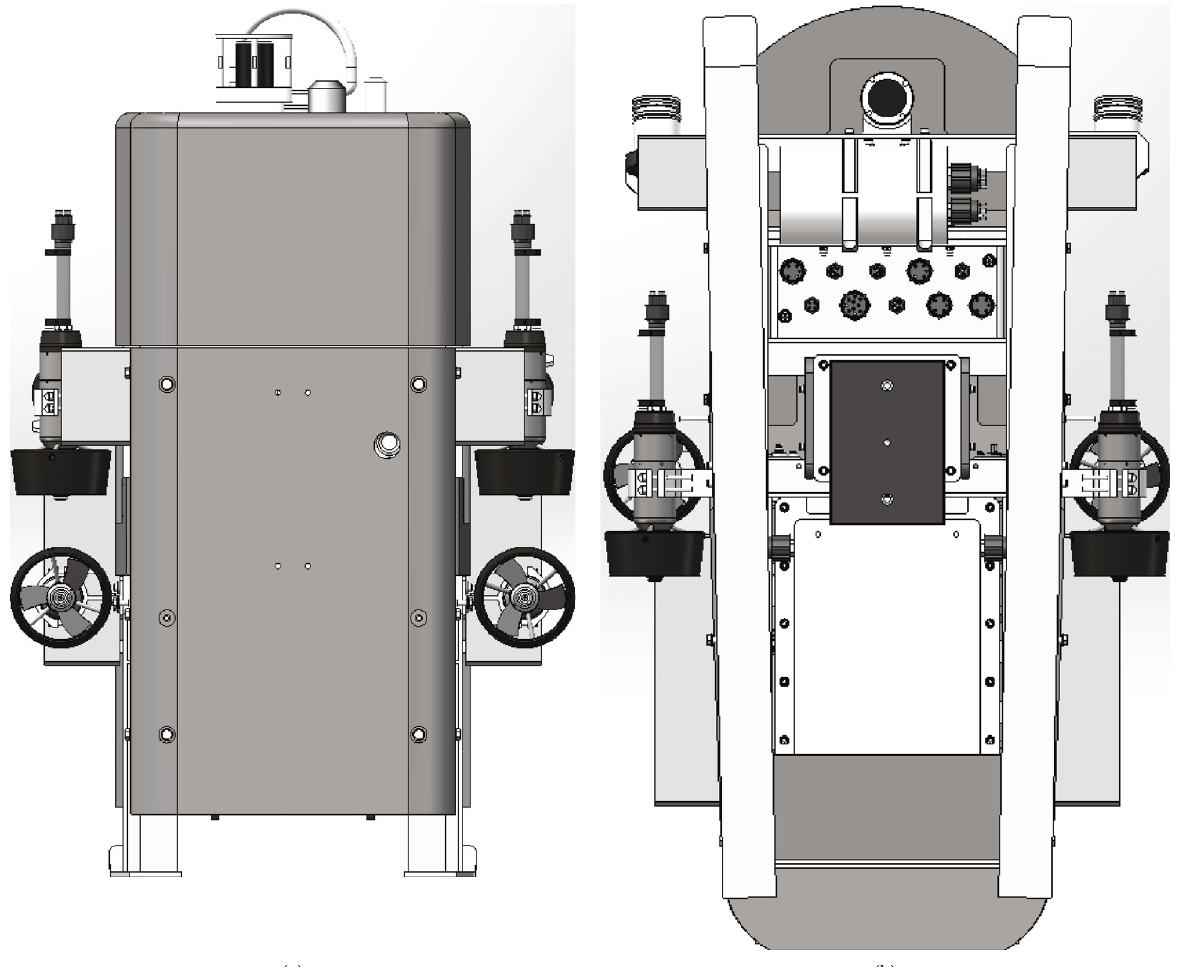
Figure 10: Diagram of thruster con fi guration: (a) rear view; (b) top